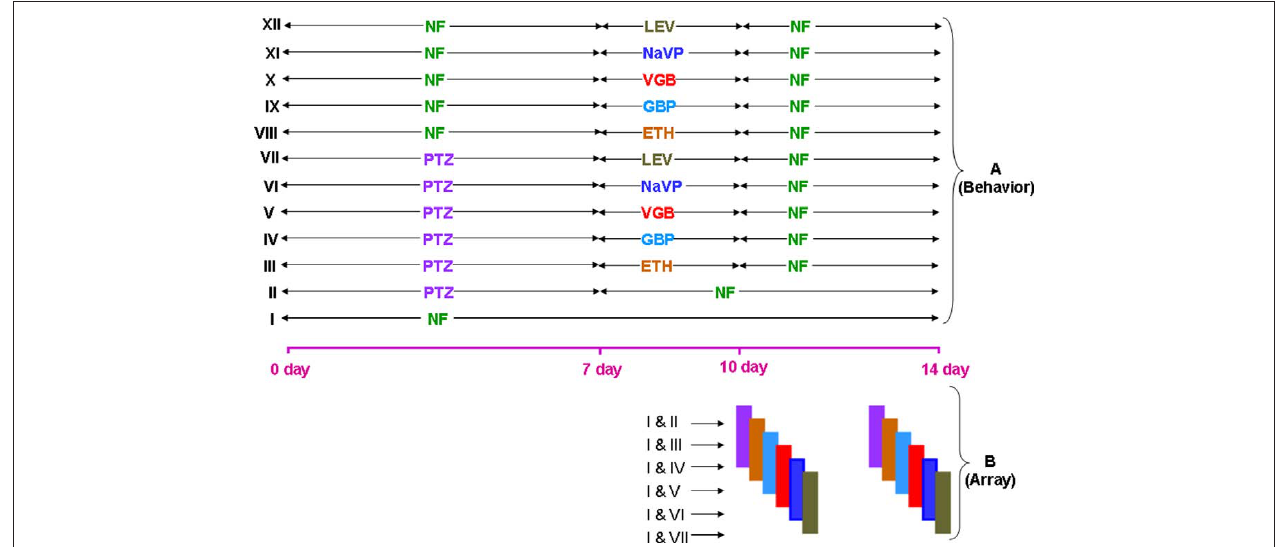
expression comparison are shown (B) . Expression profiles were generated at 10th and 14th day time-points. NF, normal food; ETH, ethosuximide; GBP, gabapentin; VGB, vigabatrin; NaVP, sodium valproate, LEV, levetiracetam. See text for